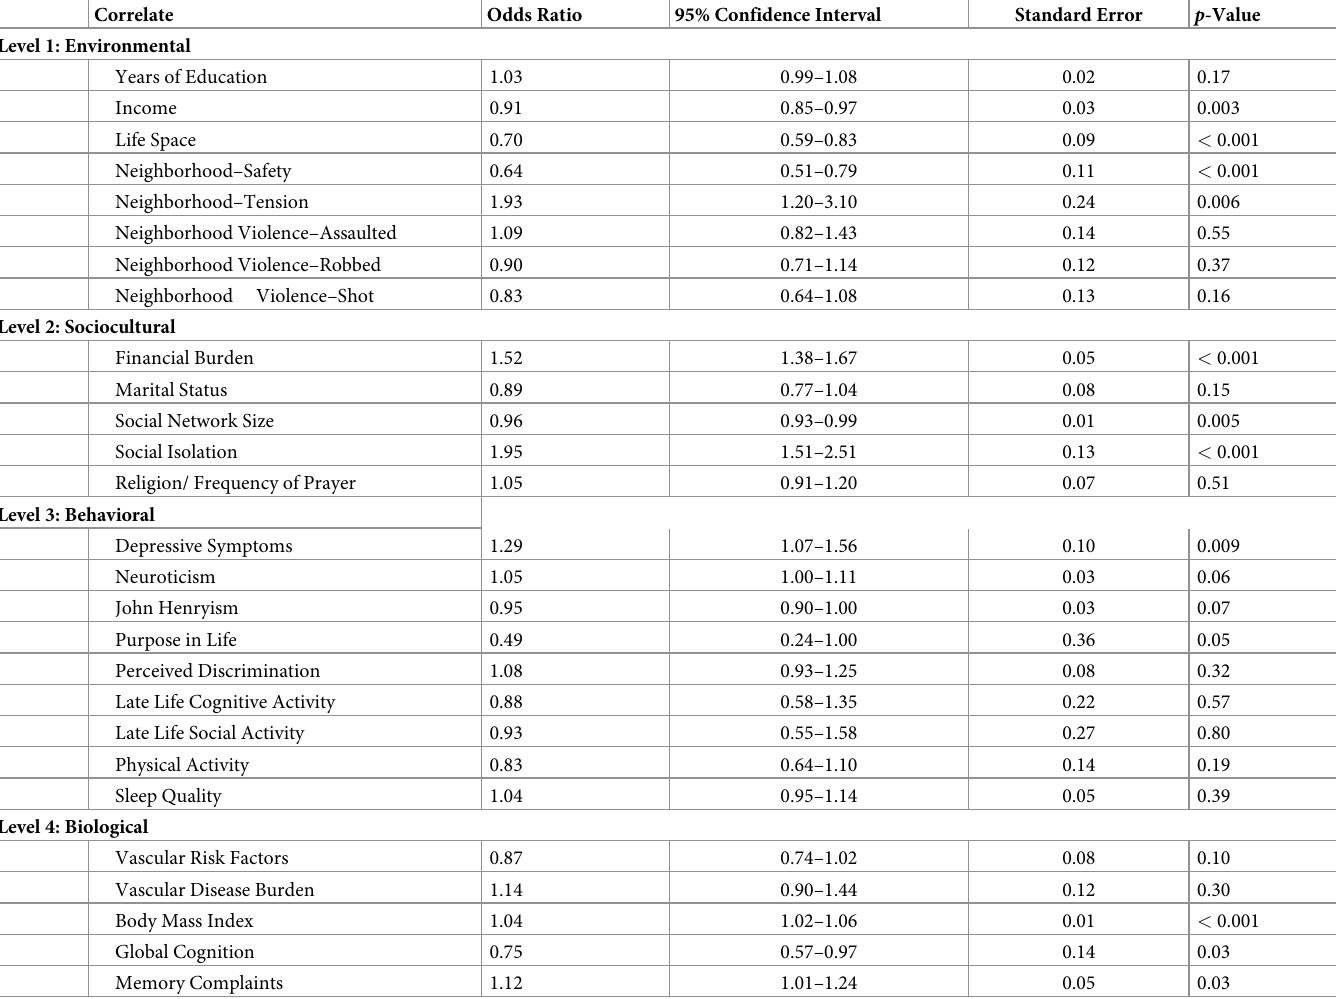
Table 3. Separate ordinal logistic regression models † for correlates grouped into four levels; with main effects for each correlate while controlling for other corre- lates within each level; perceived stress scale–quartile score is the